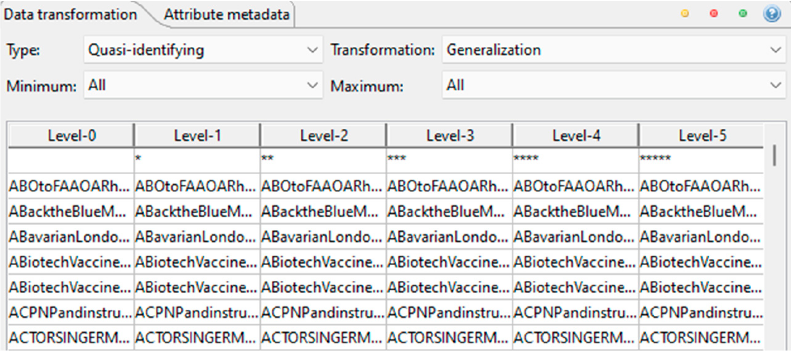
Figure 8. Hierarchy userdescription.